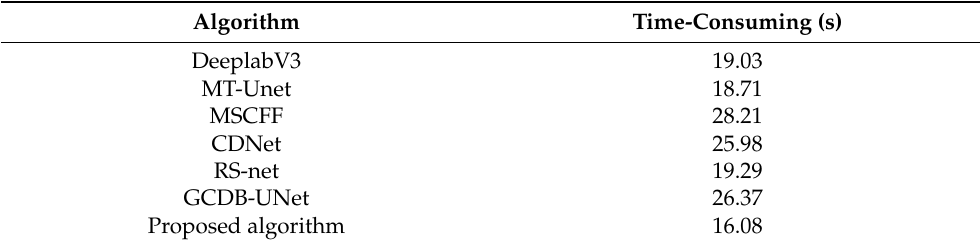
Table 9. Comparison of the computational efficiency of different deep learning